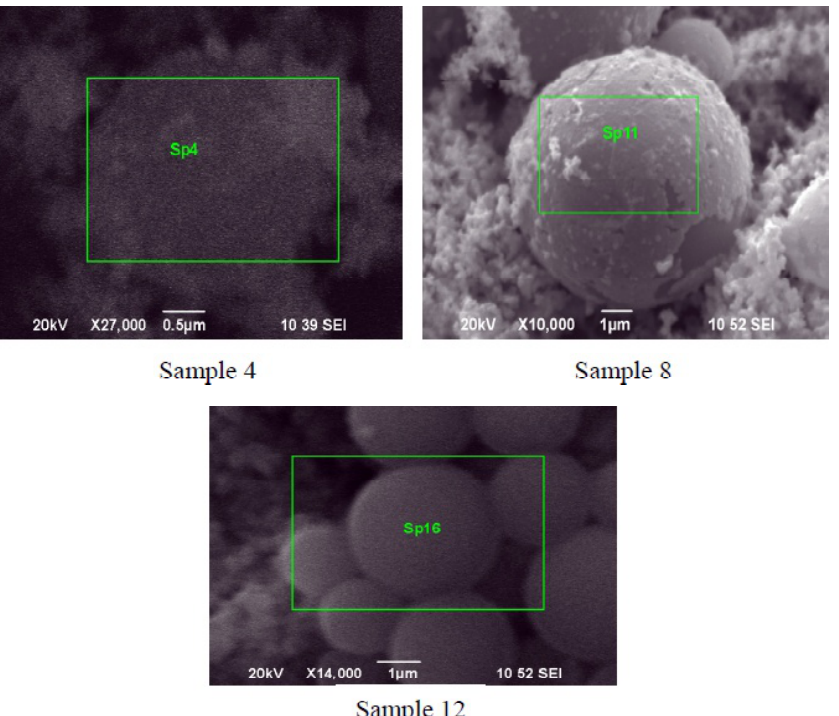
Fig. 4. SEM images of the samples synthesized with a carbon powder as a support: Sample 4-Co:Sn nanoparticles synthesized at a ratio Co:Sn=35:65, Sample 8-Ni-Sn nanoparticles synthesized at a ratio Ni:Sn=45:55, Sample 12-Co:Ni nanoparticles synthesized at a ratio